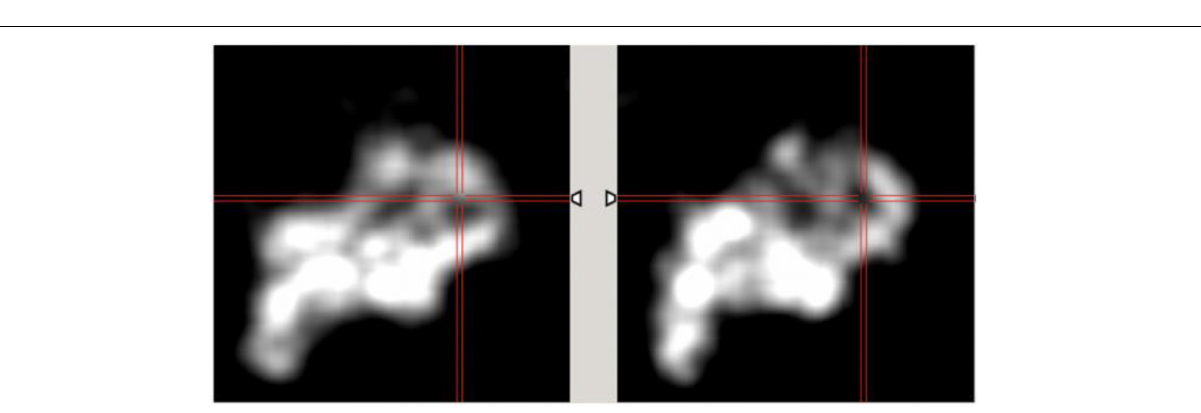
FIGURE 15 | Effect of diaphragm displacement (Case 5). The images are shown at the interval of 0.5 s after full inhalation to show the myocardial displacement due to respiration for diaphragm displacement D =